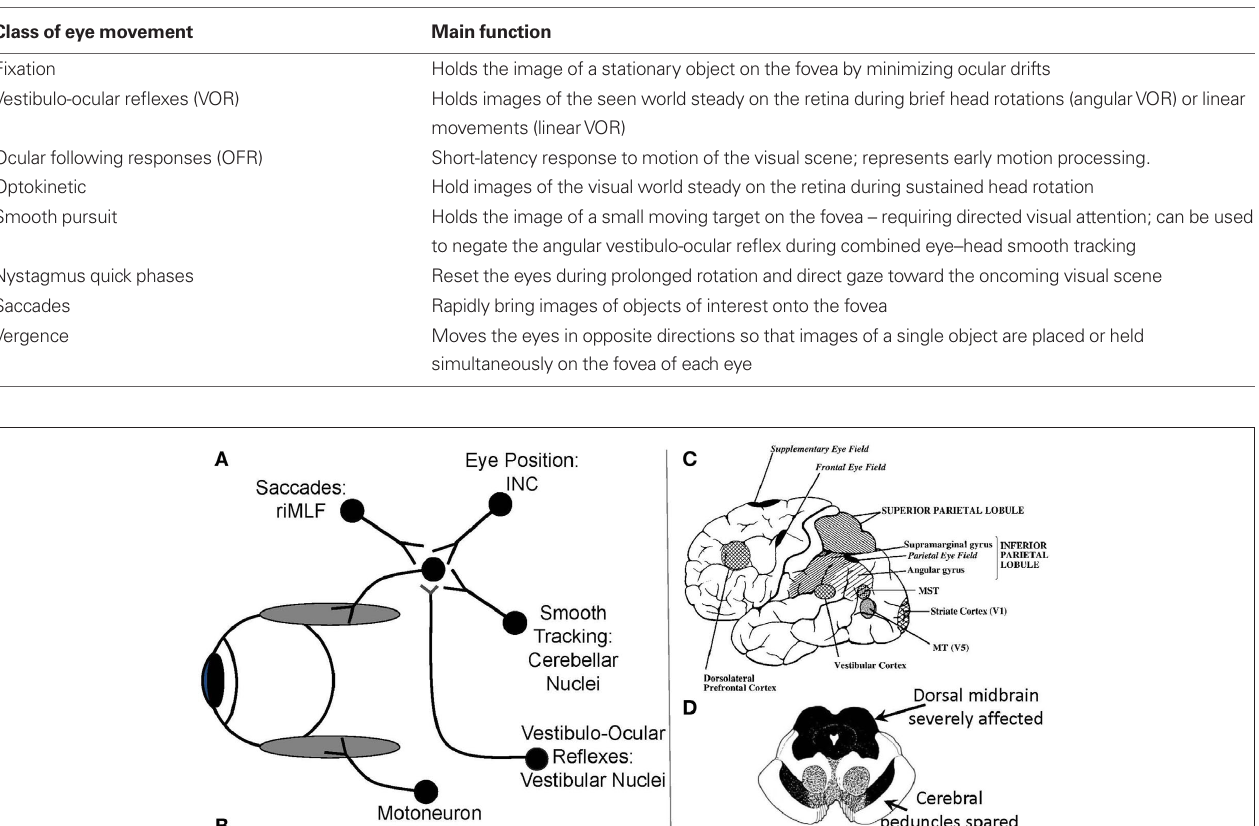
Table 1 | Functional classes of human eye